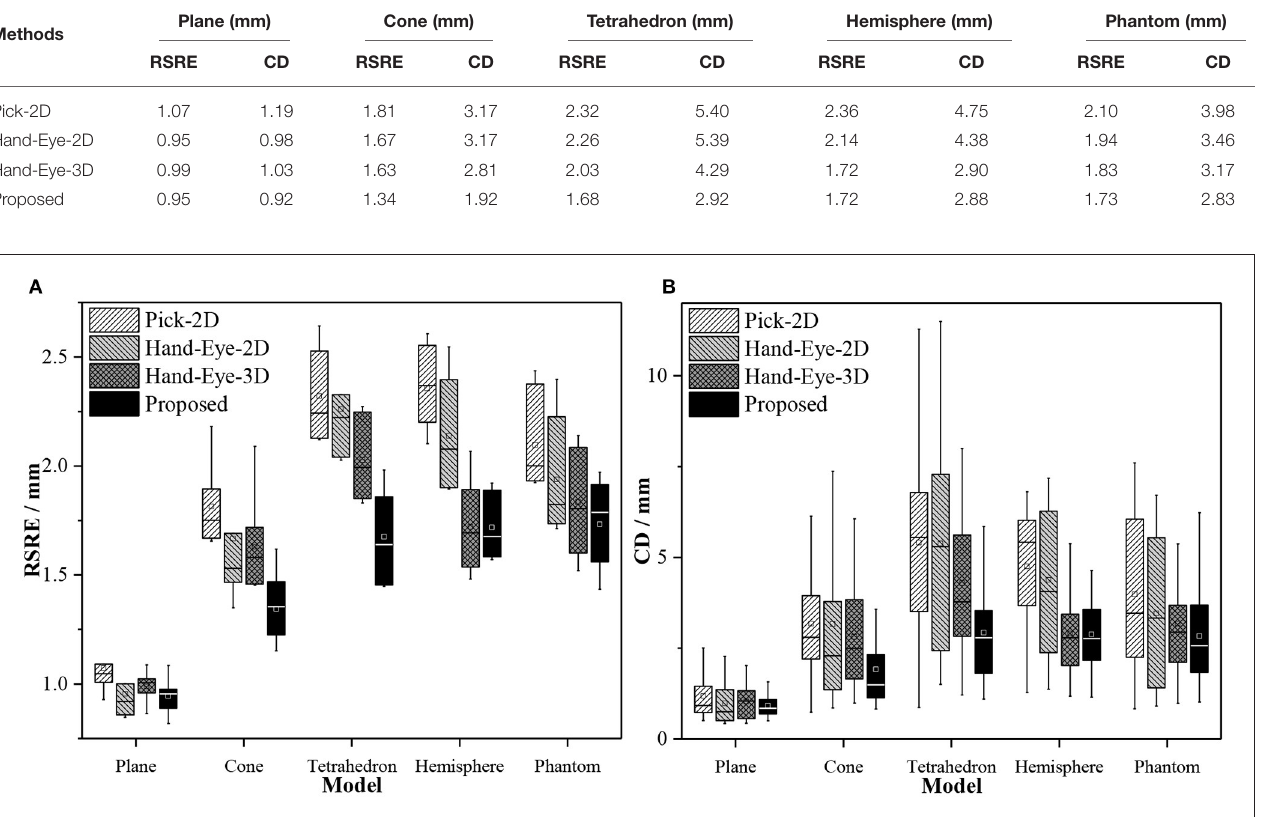
FIGURE 7 | Box plots of the accuracy comparison among different calibration methods. (A) RSRE and (B)